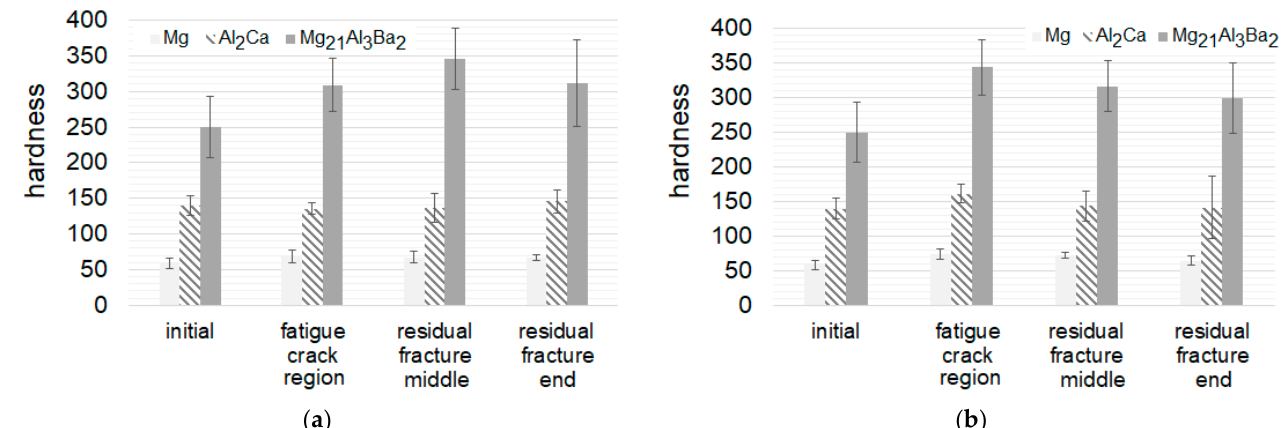
Figure 13. Bar charts of the hardness of the α -Mg grains, the lamellar Ca-rich phase Al 2 Ca and the blocky Ba-rich phase Mg 21 Al 3 Ba 2 before and after fatigue loading in different regions of the crack propagation, at R = 0 with 43,300 cycles at fracture, taken from micrograph in Figure 6 ( a ) and at R = − 1 with 12,000 cycles at fracture, taken from micrograph in Figure 8 ( b ).